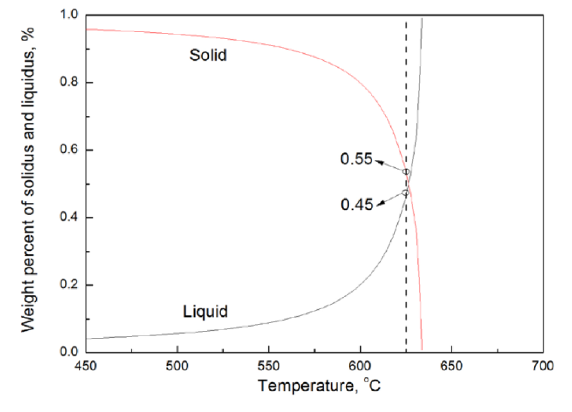
Figure 3: Solid-liquid weight fraction in the semi-solid slurry.